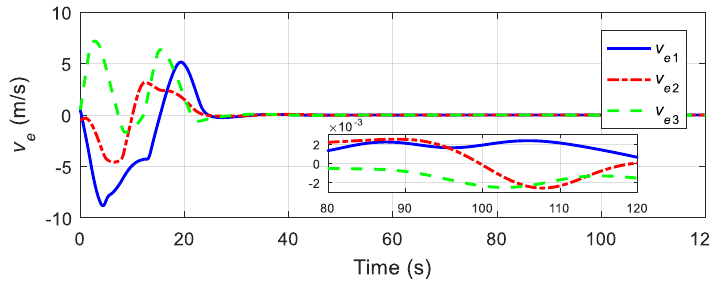
Figure 5. Relative position and velocity under the proposed controller.